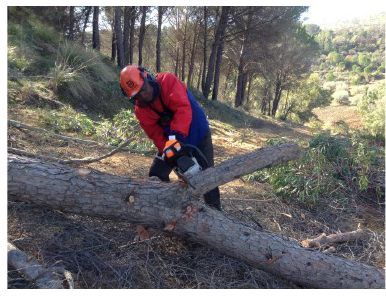
Figure 2. Tree delimbing task.